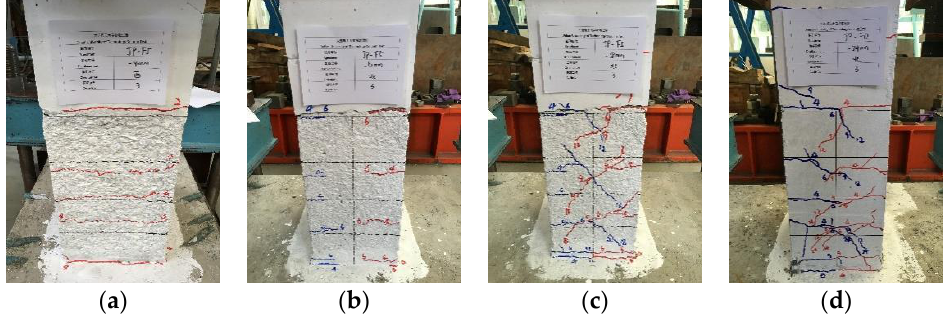
Figure 17. The cracking phenomenon of low cyclic loading test. ( a ) JP- F5(−4). ( b ) JP- F5(−6). ( c ) JP- F5(−18). ( d ) JP- F0(−24).